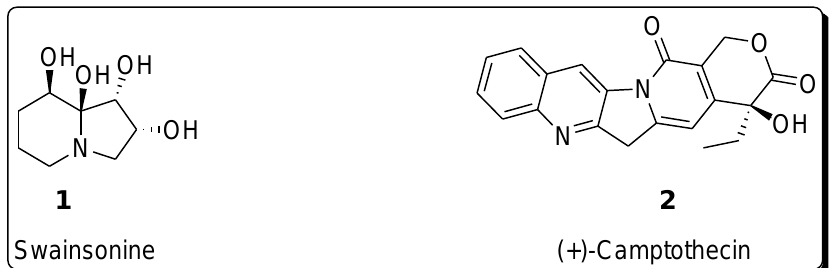
Figure 1. Structure of biologically important organic compounds employing Sharpless asymmetric dihydroxylation in their total synthesis.